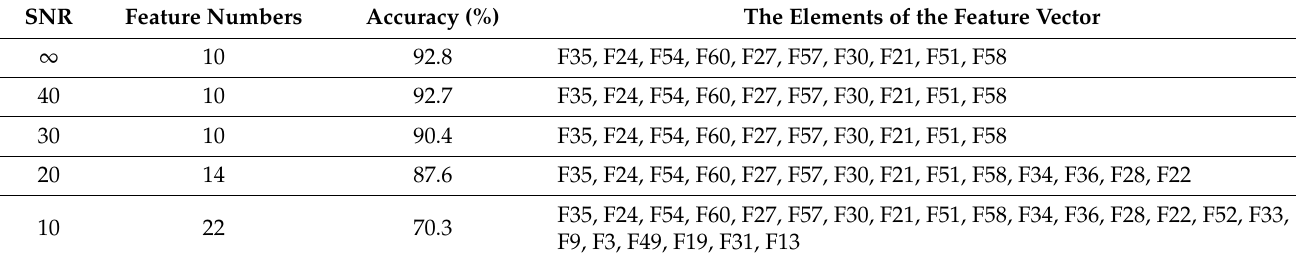
Table 5. Result of the MRA–ReliefF.